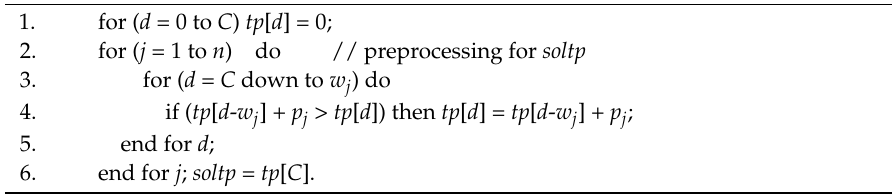
Algorithm 2: Fast DP with 1D array (for soltp , soltw ) in O( nC ).